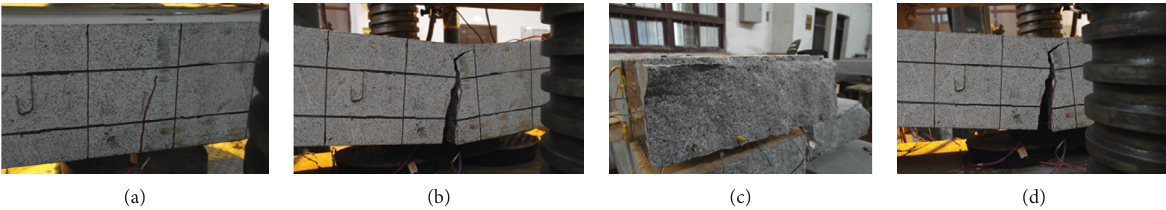
Figure 20: Failure mode of GB-3: (a) initial vertical crack; (b) fully crack; (c) steel bars; (d) final failure mode.